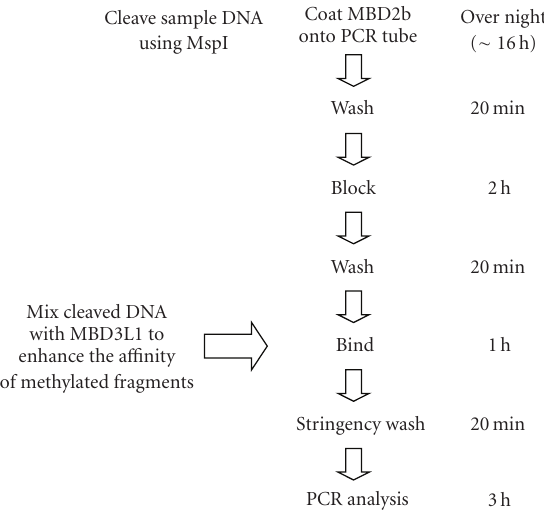
Figure 2: Flow diagram of methyl-CpG-binding